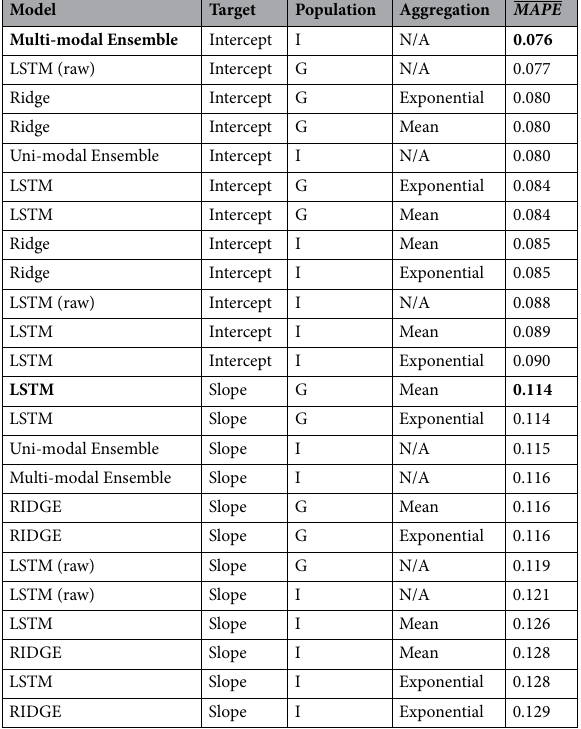
Table 2. Summary of models performances according to intercept and slope coefficients. MAPE represents the averaged MAPE over individuals and validation folders. The population represents either models computed over the group of players (G) or individually computed models (I). Significant values are in